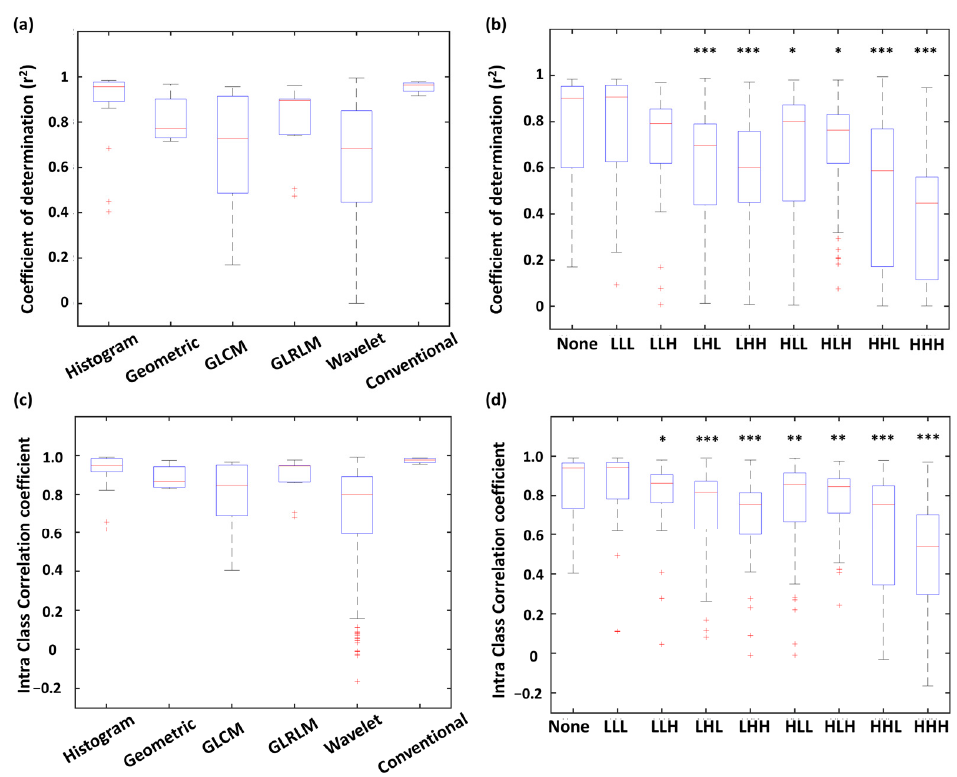
Figure 3. Distribution of r 2 ( a , b ) and ICC ( c , d ) values of PET/CT and PET/MR comparison among radiomic types and wavelet types. *** p < 0.001, ** p < 0.01, * p < 0.05.